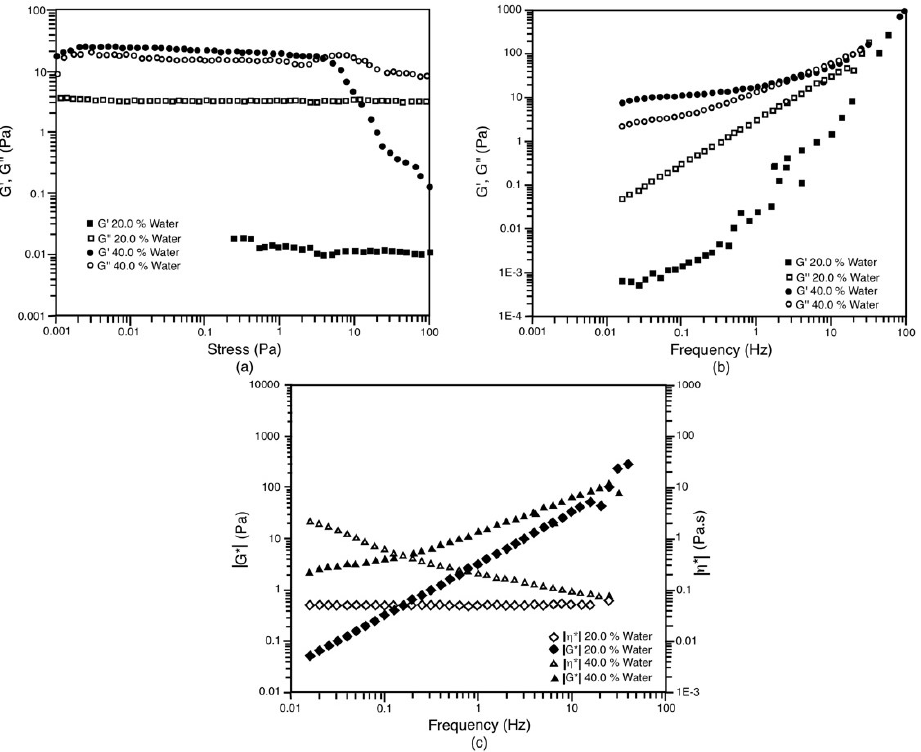
Figure 8. Oscillatory tests for the system with the dilution line S/O = 70/30 at 30 °C. The liquid crystal is in equilibrium with the Om phase and the Om and Wm phases in the case of 20% and 40% of water, respectively. ( a ) Amplitude shear stress sweep at 1 Hz; ( b ) Frequency sweep at 0.1 Pa; ( c ) Evolution of |G*| and | η *| against frequency.